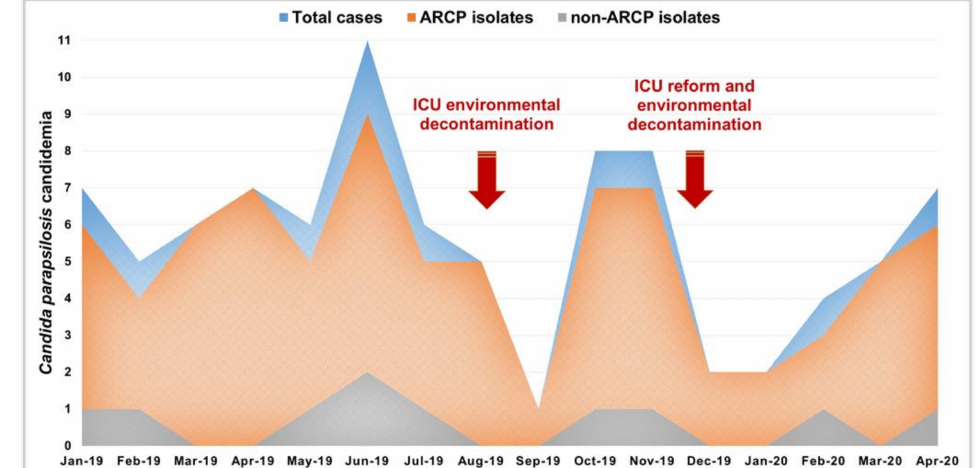
Figure 2. Candidemia cases by azole-resistant C. parapsilosis (ARCP) or non-ARCP in the adult oncology intensive care unit (ICU) from January 2019 to April 2020. The red arrows indicate the two decontamination efforts of the ICU environment with quaternary ammonium